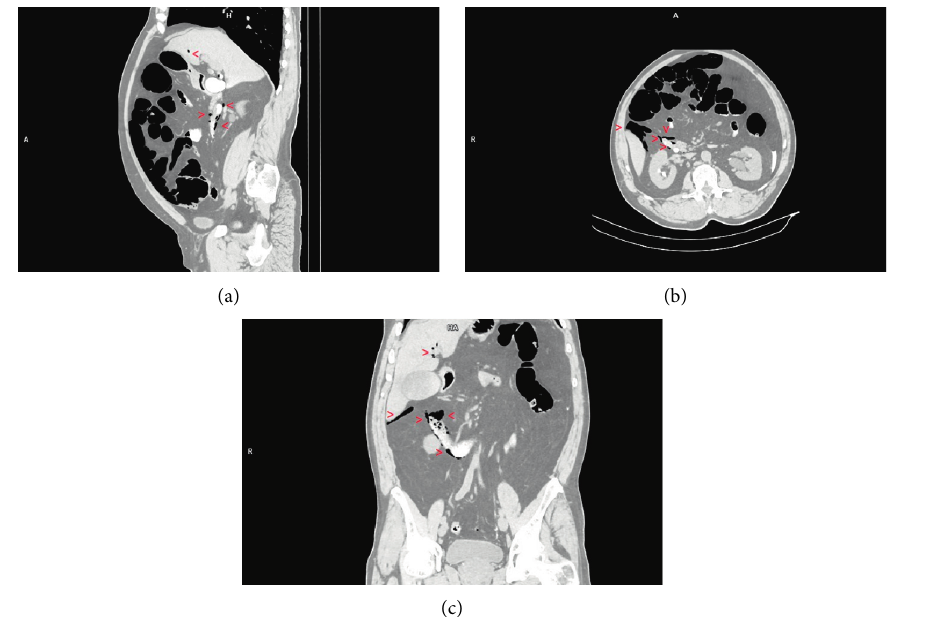
Figure 2: CT—free air around the duodenum in level of the papilla around the liver and visible retroperitoneum around the liver.